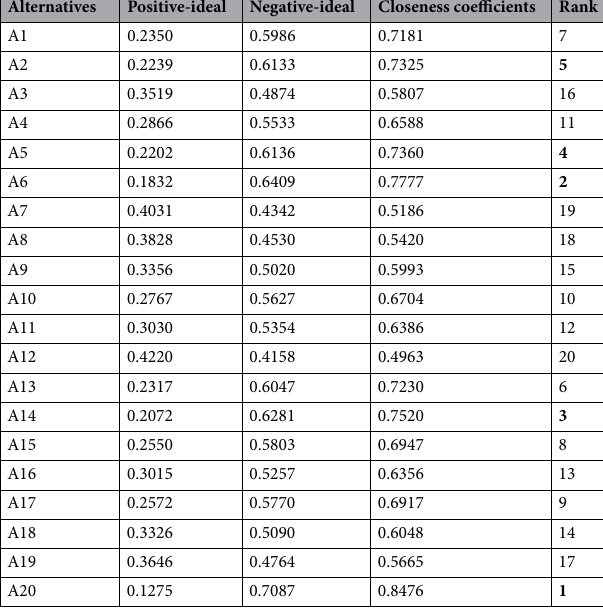
Table 6. Positive and negative distances, closeness coefficients and the rank of